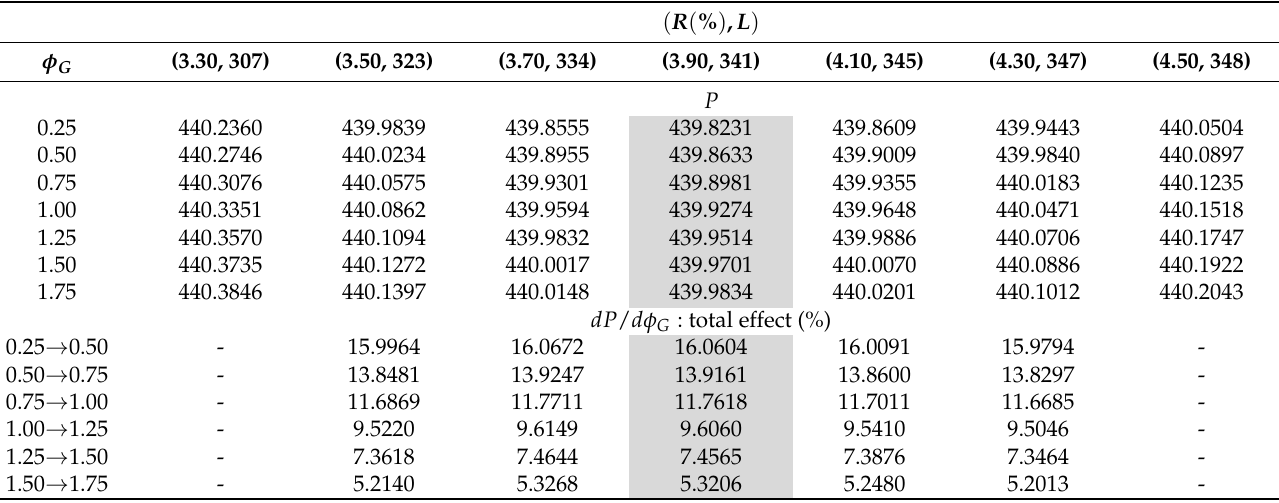
Table 9. Responsiveness of P to φ G .